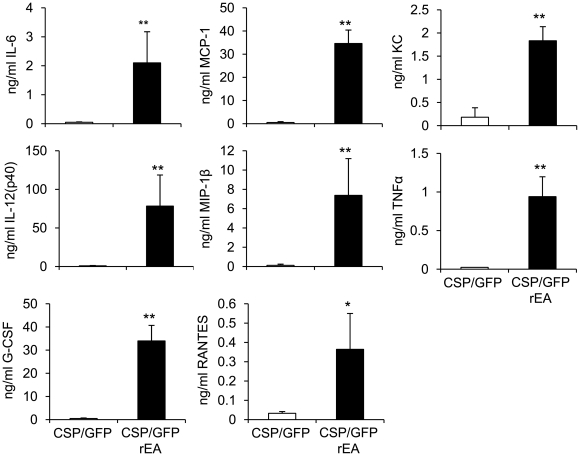
TLR agonist, rEA, induced innate cytokines 6 hours post injection.Co-injection of Ad-GFP/rEA and Ad-CSP stimulated robust expression of innate cytokines and chemokines as compared to the control vaccine. BALB/cJ mice were injected IV with either 3.75×1010 vps/mouse of Ad-CSP+Ad-GFP or 3.75×1010 vps/mouse Ad-GFPrEA+Ad-CSP. Plasma was collected at 6 hours post injection. Plasma cytokine/chemokine levels were measured with a mouse multiplexed bead array based quantitative system. The bars represent mean ± SD. Statistical analysis was completed using One Way ANOVA with a Student-Newman-Keuls post-hoc test, *,** denotes significance between treatments, p<0.05, p<0.01.